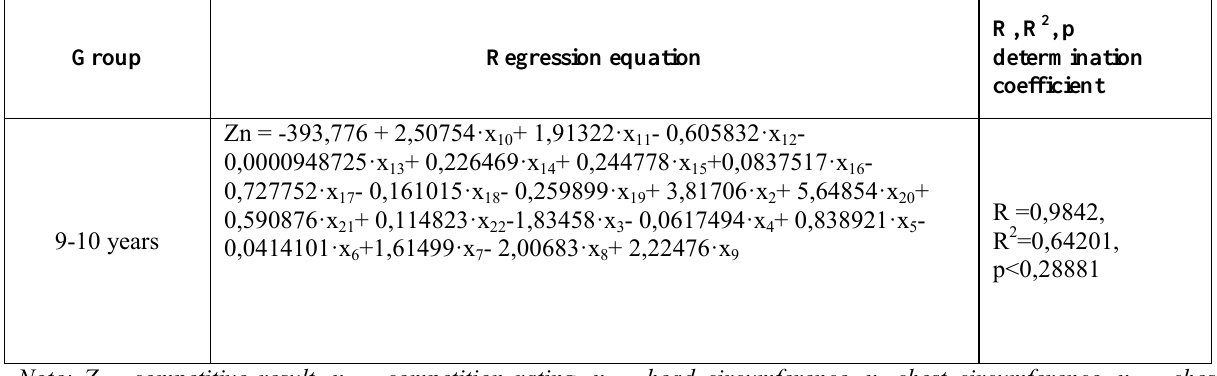
Competitive Performance-Anthropometric and Motoric Test Data Regressive Model for Children Aged 9-10 Group Regression equation